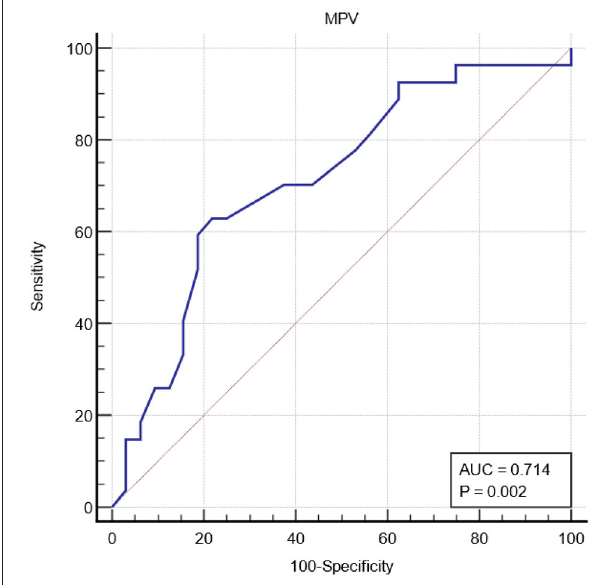
FIGURE 2 | Receiver operating characteristic curve ROC of mean platelet volume (MPV) for influenza respiratory tract